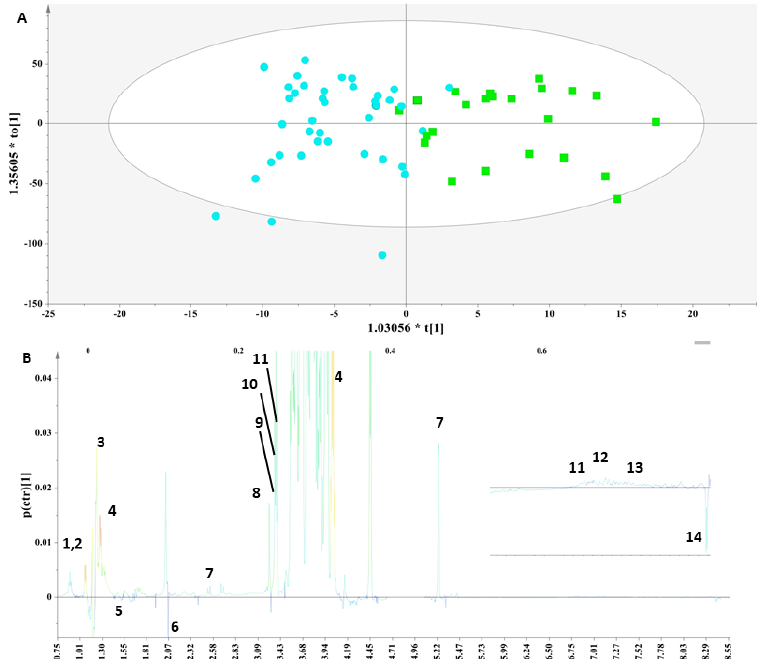
Figure 3. ( A ) OPLS-DA model; A = 1 + 1, N = 62; R 2 X(cum)= 0.85 and R 2 Y(cum) = 0.62; Q 2 (cum) = 0.49. Green squares = samples with thyroid disorder and blue circles= control samples. ( B ) S-line plot (1: leucine (2-amino-4-methylpentanoic acid), 2: isoleucine (2-amino-3-methylpentanoic acid),